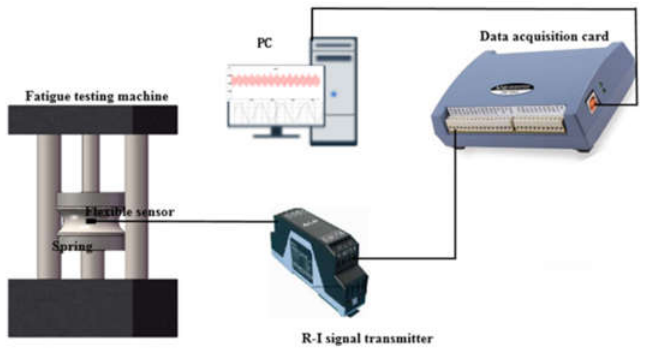
Figure 8. Overall diagram of the testing device.